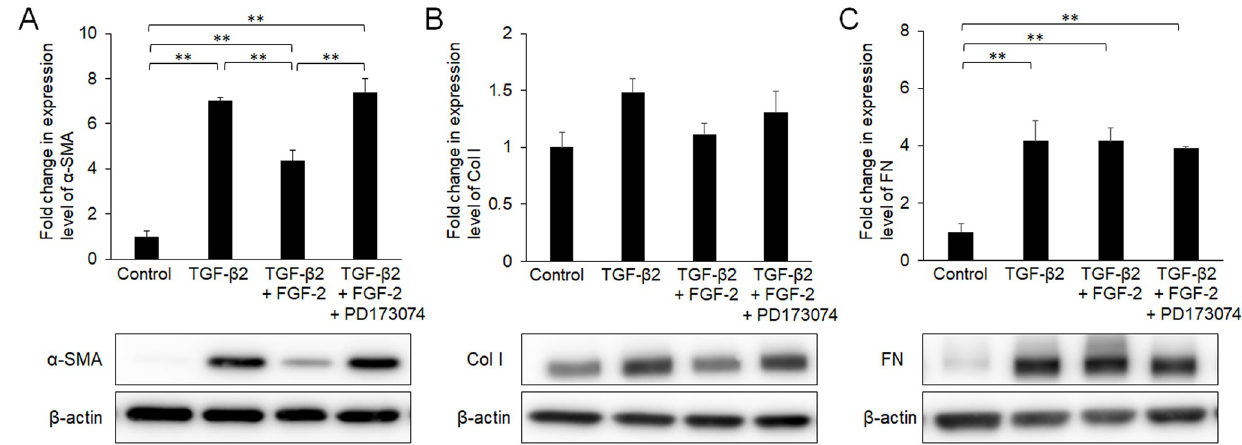
Fig 2. Effects of fibroblast growth factor (FGF)-2 and the FGF receptor inhibitor PD173074 on α -smooth muscle actin (SMA), collagen type I (Col I), and fibronectin (FN) expression. Conjunctival fibroblasts were treated with a combination of 10 ng/mL FGF-2, 30 nM PD173074, and 2.5 ng/mL transforming growth factor (TGF)- β 2 for 48 h and subjected to Western blot analysis. The suppressive effect of FGF-2 on α -SMA (A) was diminished by PD173074, which did not affect Col I (B) or FN (C) significantly. �� p < 0.01. Data are shown as the mean ± SE, n = 3.